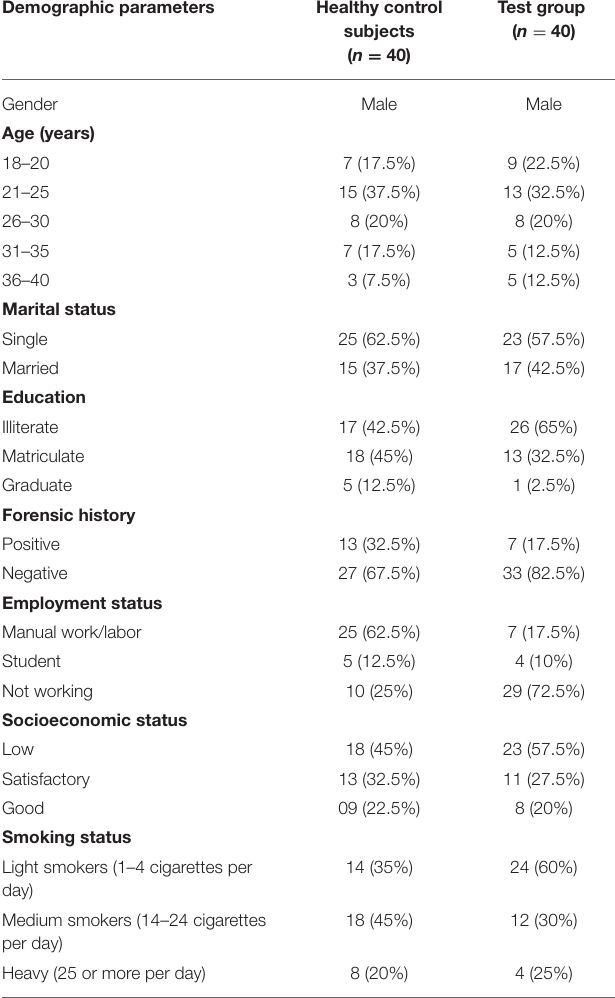
TABLE 1 | Demographic details of healthy control subjects vs. test group who participated in the study regarding psychiatric, biochemical, and physiological